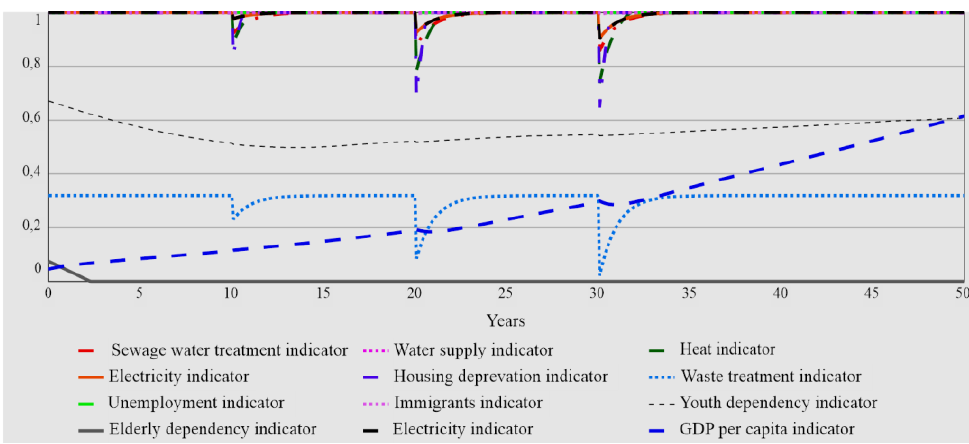
Fig.5. Output of indicators for Urban Resilience SD model simulation without occurrence of natural